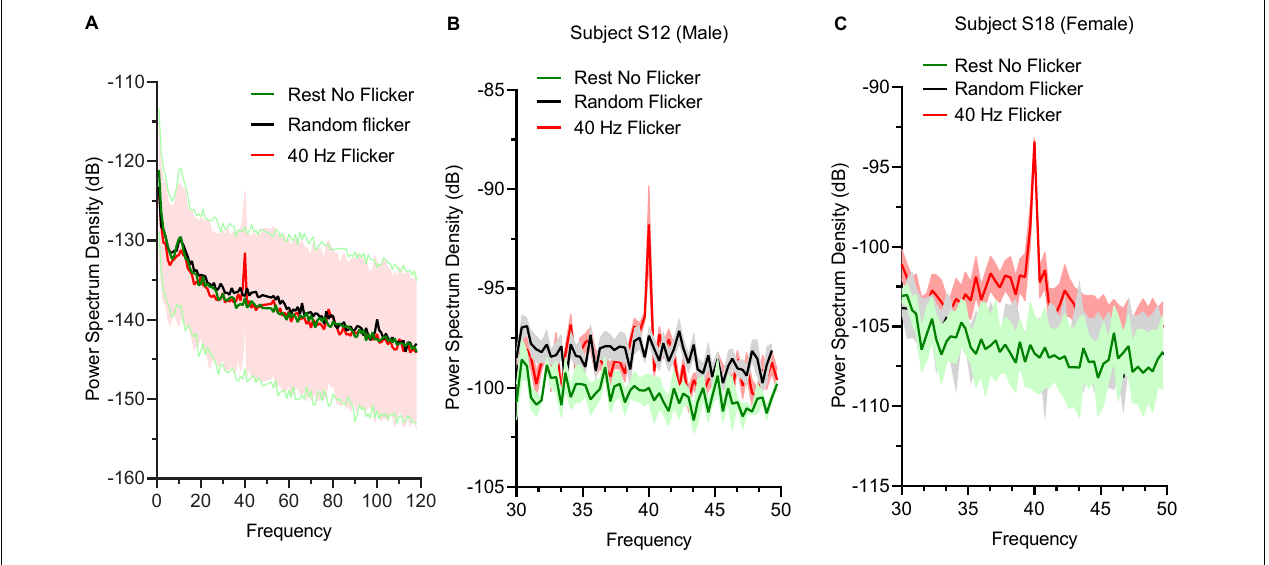
FIGURE 2 | Power spectral density responses during rest state and light flicker stimulation. (A) Quantification of PSD in different states displayed in decibel (dB) unit. Thick lines in green, black, and red showed the mean values and shaded areas represented SEM; (B) PSD between 30 and 50 Hz of a male subject (B) and a female subject (C)